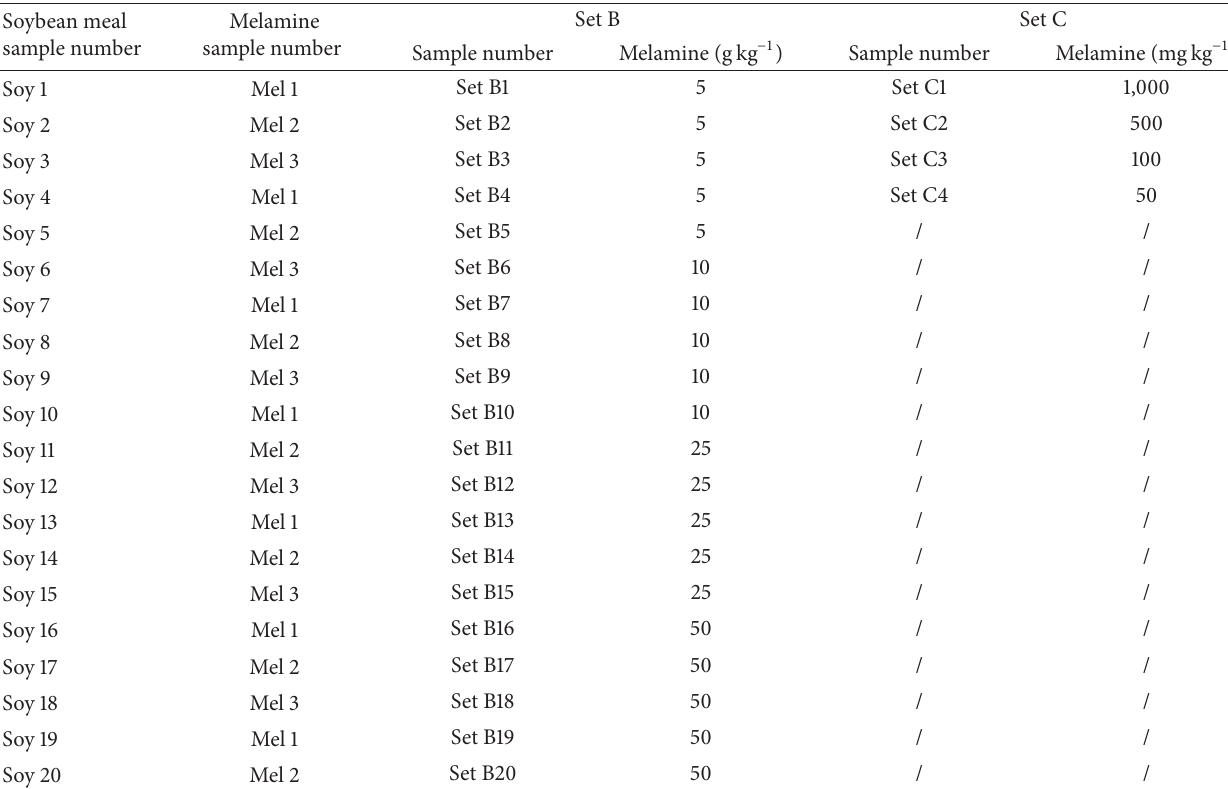
Table 1: Description of the samples Set B and Set